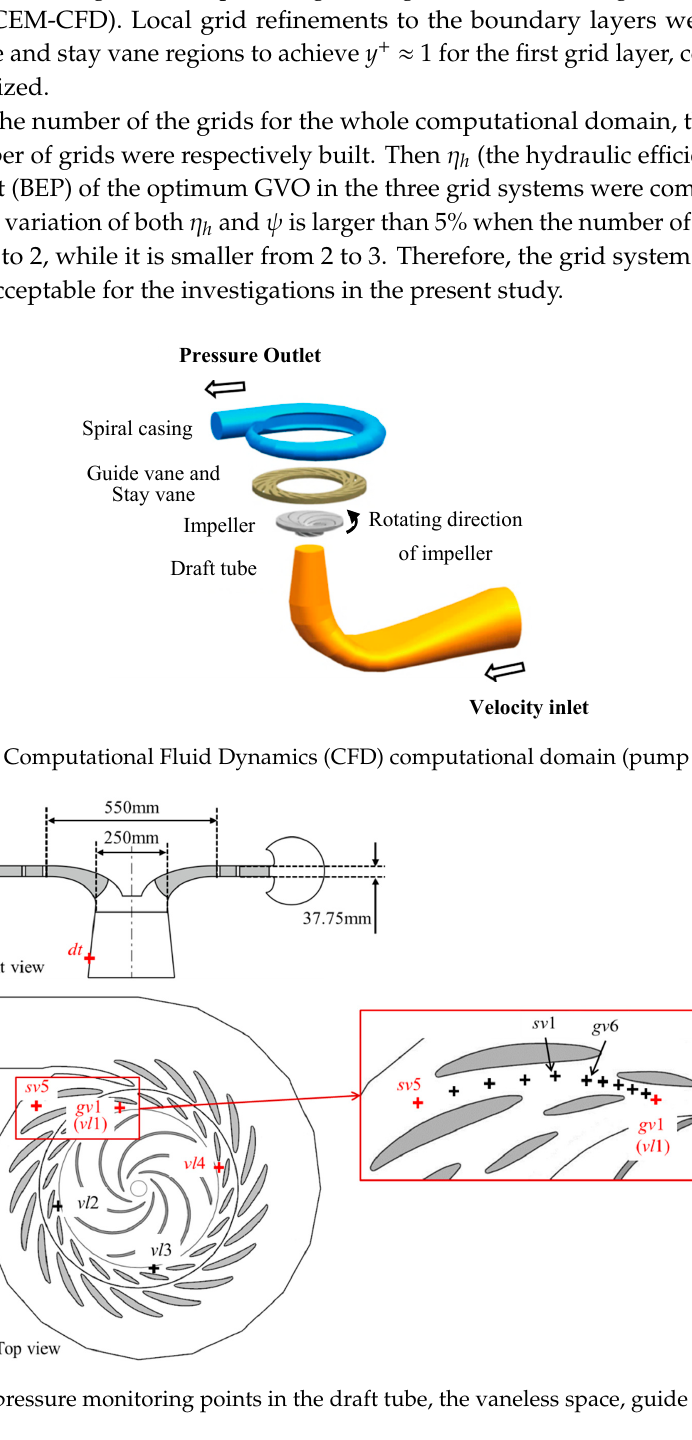
(b) Figure 6. Planes for data analysis ( a ) The middle spanwise hub-to-shroud surface and ( b ) the guide vane symmetry plane. Table 2. η h and H at BEP of the optimum GVO in the three grid systems. Number of grids η h (%)